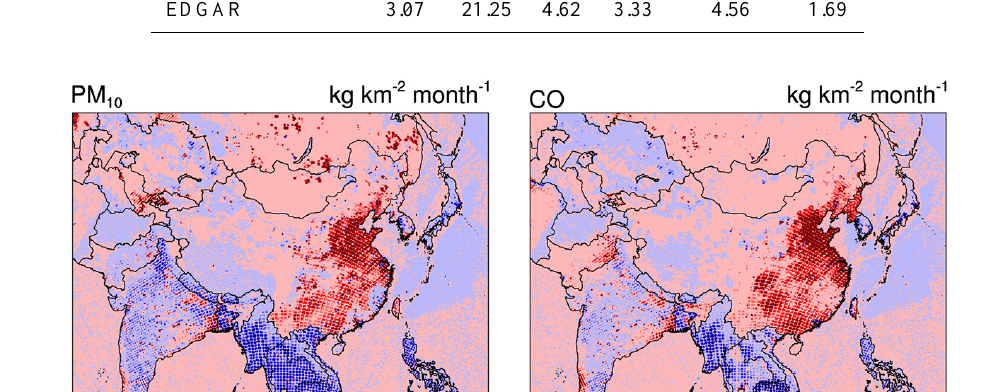
cursors of Ozone and their Effect on the Troposphere ver- sion 1 (POET) emissions inventory (Granier et al., 2005).